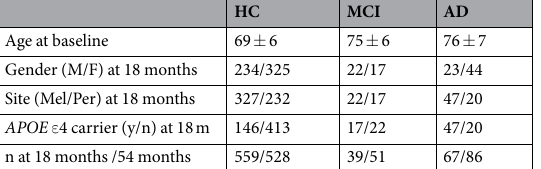
Table 1. Demographic data for our cohort. (a) Data are represented as Mean ± S.E or as number of cases overall.